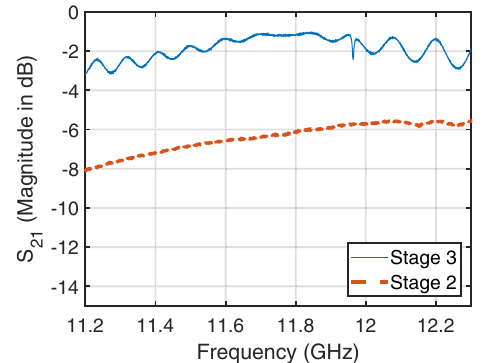
FIG. 4. Comparison of S 21 measurements showing the reduc- tion in transmission loss in the Stage III